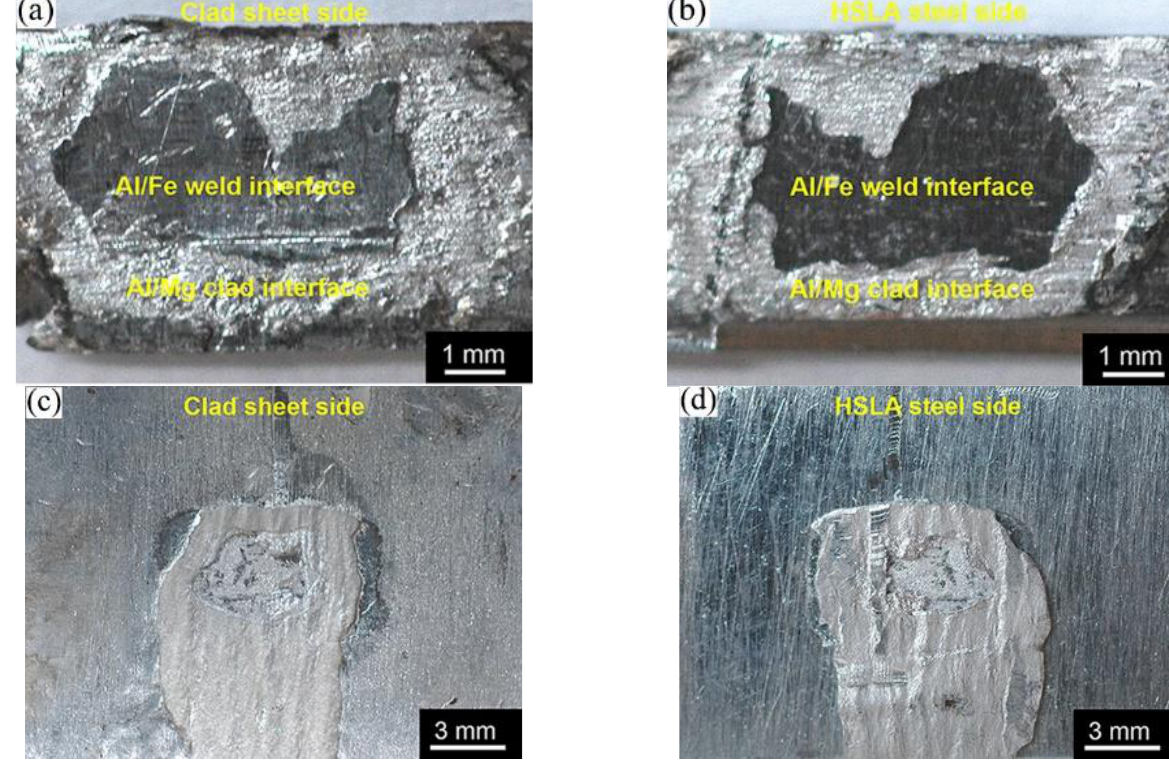
Figure 26. Macroscopic images of the separated samples of USW Al/Mg/Al-clad-sheet-to-HSLA- steel joint [37]: ( a ) clad sheet side without Zn coating; ( b ) steel side without Zn coating; ( c ) clad sheet side with Zn coating; ( d ) steel side with Zn coating.